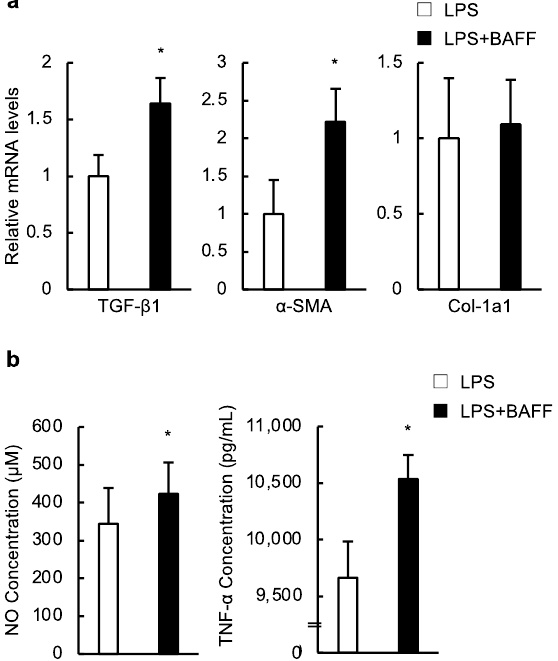
Figure 6. BAFF-treated macrophages generate inflammatory cytokines and activate hepatic stellate cells (HSCs). ( a ) Expression of genes on HSCs following the culture with CM from BAFF and LPS- treated-RAW264.7 cells ( n = 8–13/group); ( b ) NO (left: n = 13/group) and TNF- α concentration (right: n = 7/group) in CM from BAFF-treated RAW264.7 cells in addition to LPS were analyzed by parameter NO assay and ELISA, respectively. For all bar plots shown, data represent mean ± standard error of the mean. * p < 0.05. BAFF, B cell-activating factor; CM, conditioned medium; LPS, lipopolysaccharide; TGF, transforming growth factor; α -SMA, α -smooth muscle actin; Col, collagen; NO, nitric oxide; TNF, tumor necrosis factor; ELISA: enzyme-linked immunosorbent assay.